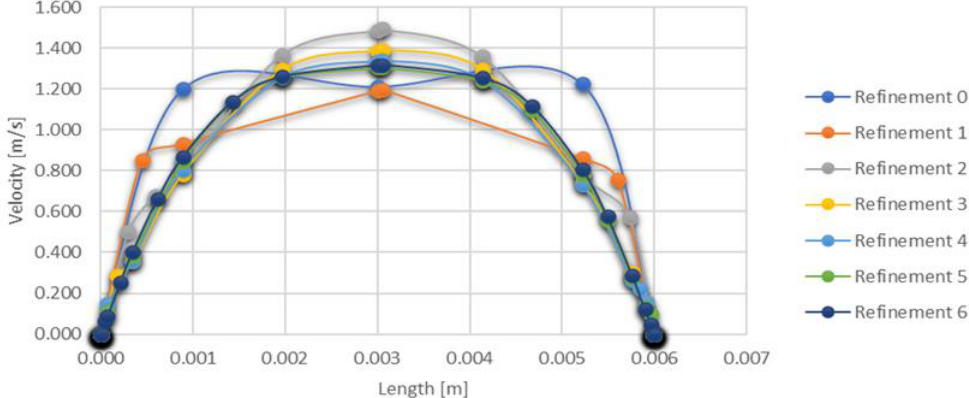
Figure 5. Figure 5. Velocity versus length for different mesh refinements for geometry with lateral air inlet and outlet.